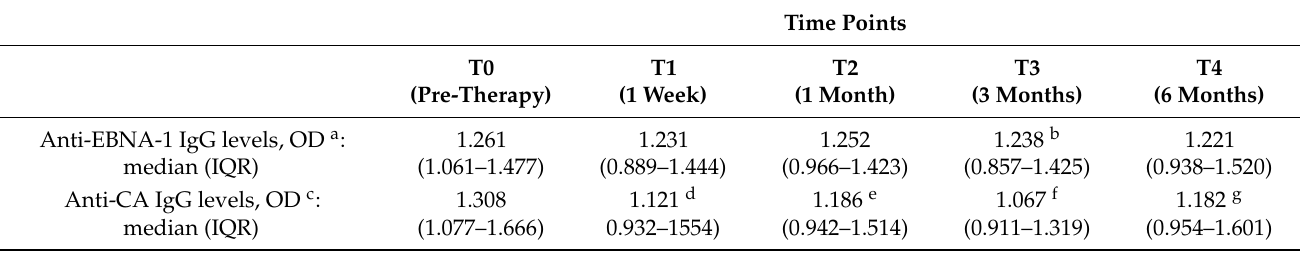
Table 2. Longitudinal fluctuations in serum levels of anti-Epstein–Barr virus nuclear antigen-1 (EBNA- 1) and anti-capsid antigen (CA) IgG expressed as optical density (OD) in 17 relapsing–remitting multiple sclerosis patients during six months of dimethyl fumarate